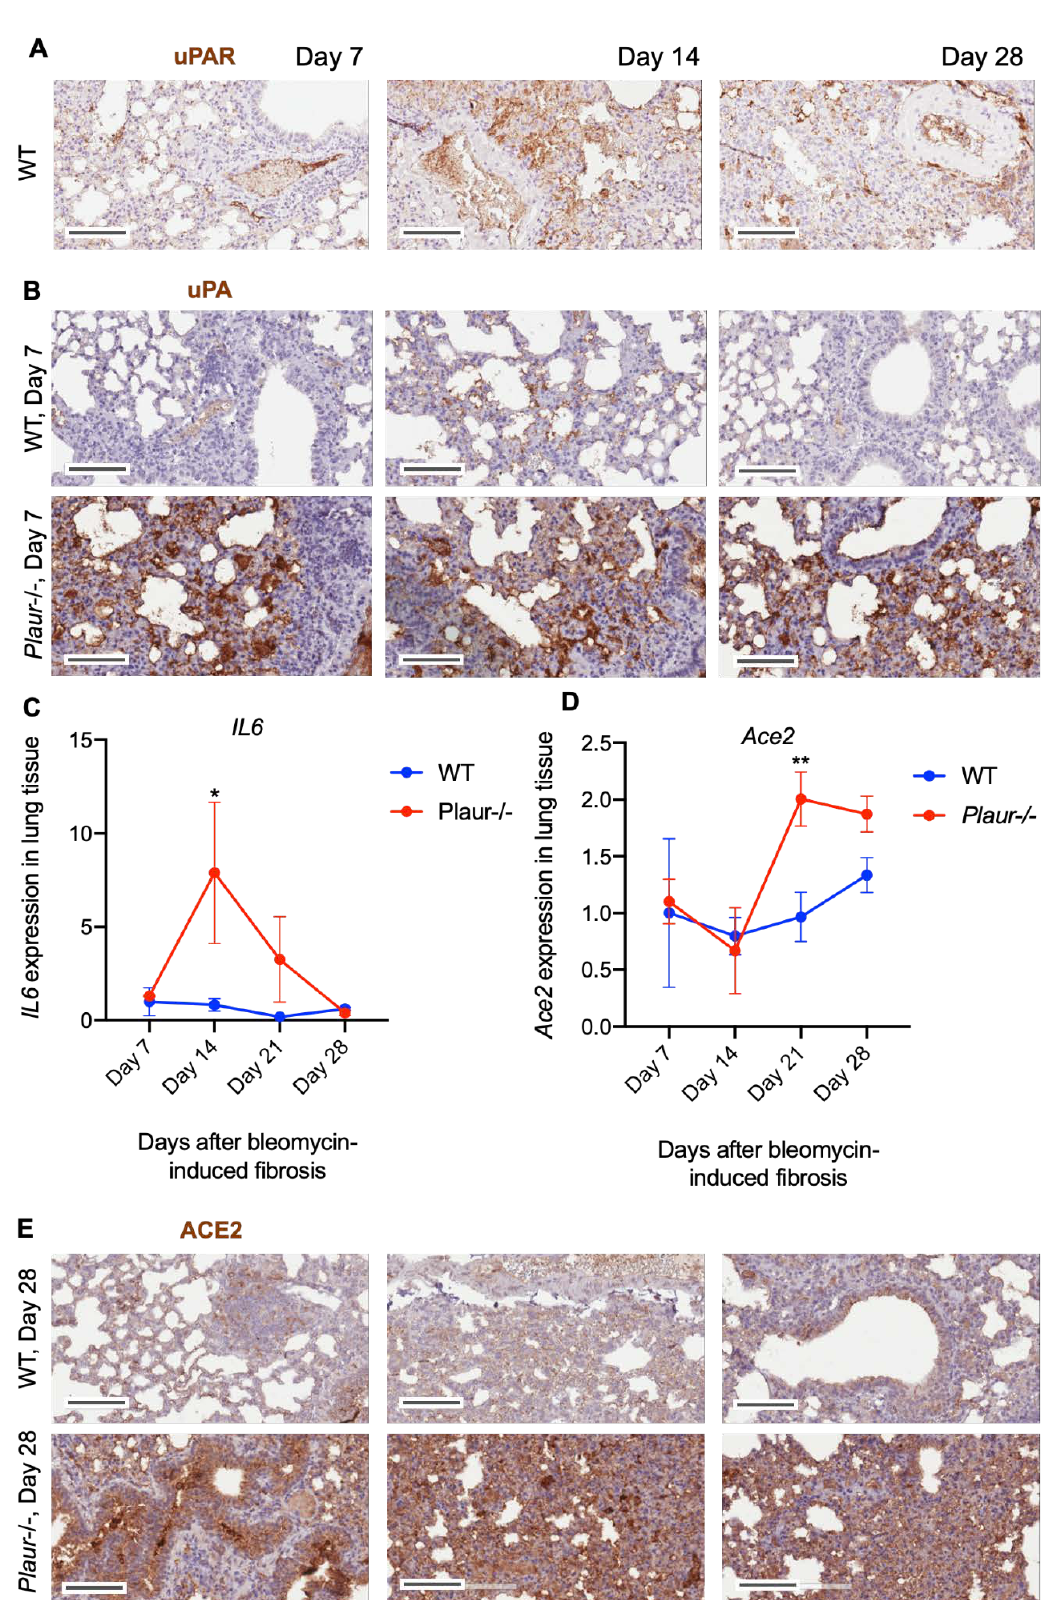
Figure 6. uPAR deficiency led to uPA accumulation and increased IL-6 and ACE2 expression in lung tissue following bleomycin-induced lung damage: ( A ) Representative sections of lung tissue from wild-type (WT) mice 7, 14 or 28 days after instillation with bleomycin, stained for uPAR. uPAR was re- vealed with DAB chromogen substrate (brown). The scale bar in images is 100 µ m. ( B )